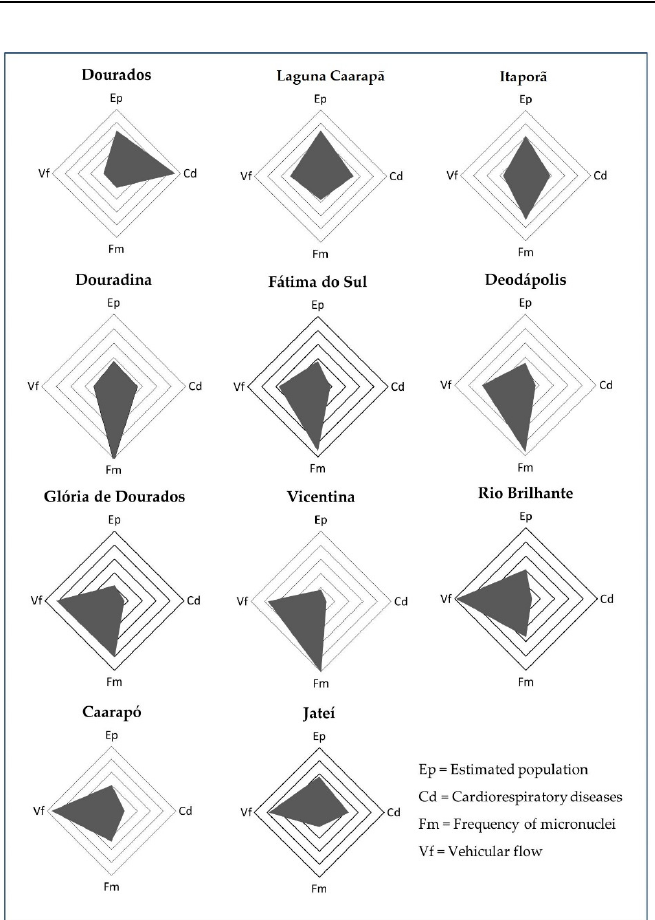
Figure 1. Analysis of the Tetrad of Pollution Indicators used for the eleven cities in the microregion of Dourados. The patterns presented above can be corroborated by the analysis of the correlation between the presented indicators and other environmental variables (Table 2). A high pos- itive correlation was observed between frequency of micronuclei and vehicular flow; a lower significance between the number of the diseases and the estimated total population, followed by the frequency of micronuclei and the estimated total population. Tempera- ture and average rainfall were negatively correlated with total registered diseases.